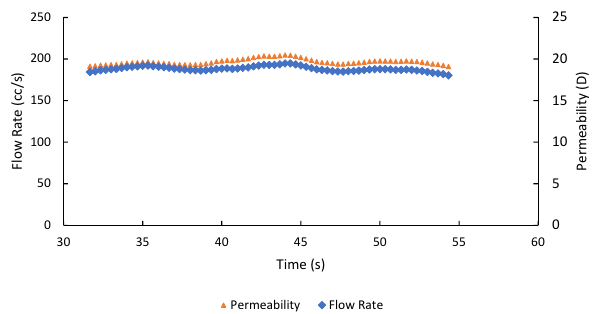
Fig. 5 Flow rates effect on recorded permeability